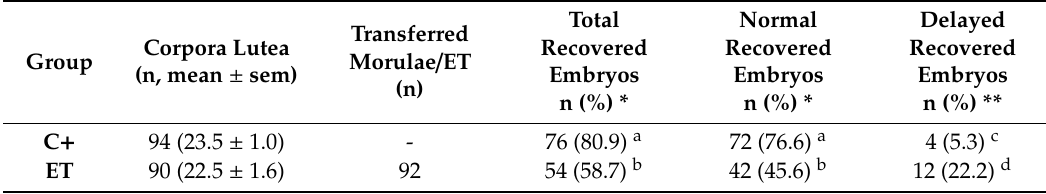
Table 1. Pig embryos recovered at D24 of pregnancy in sows following artificial insemination (N = 4; C+) or embryo transfer of morulae (N = 4; ET).